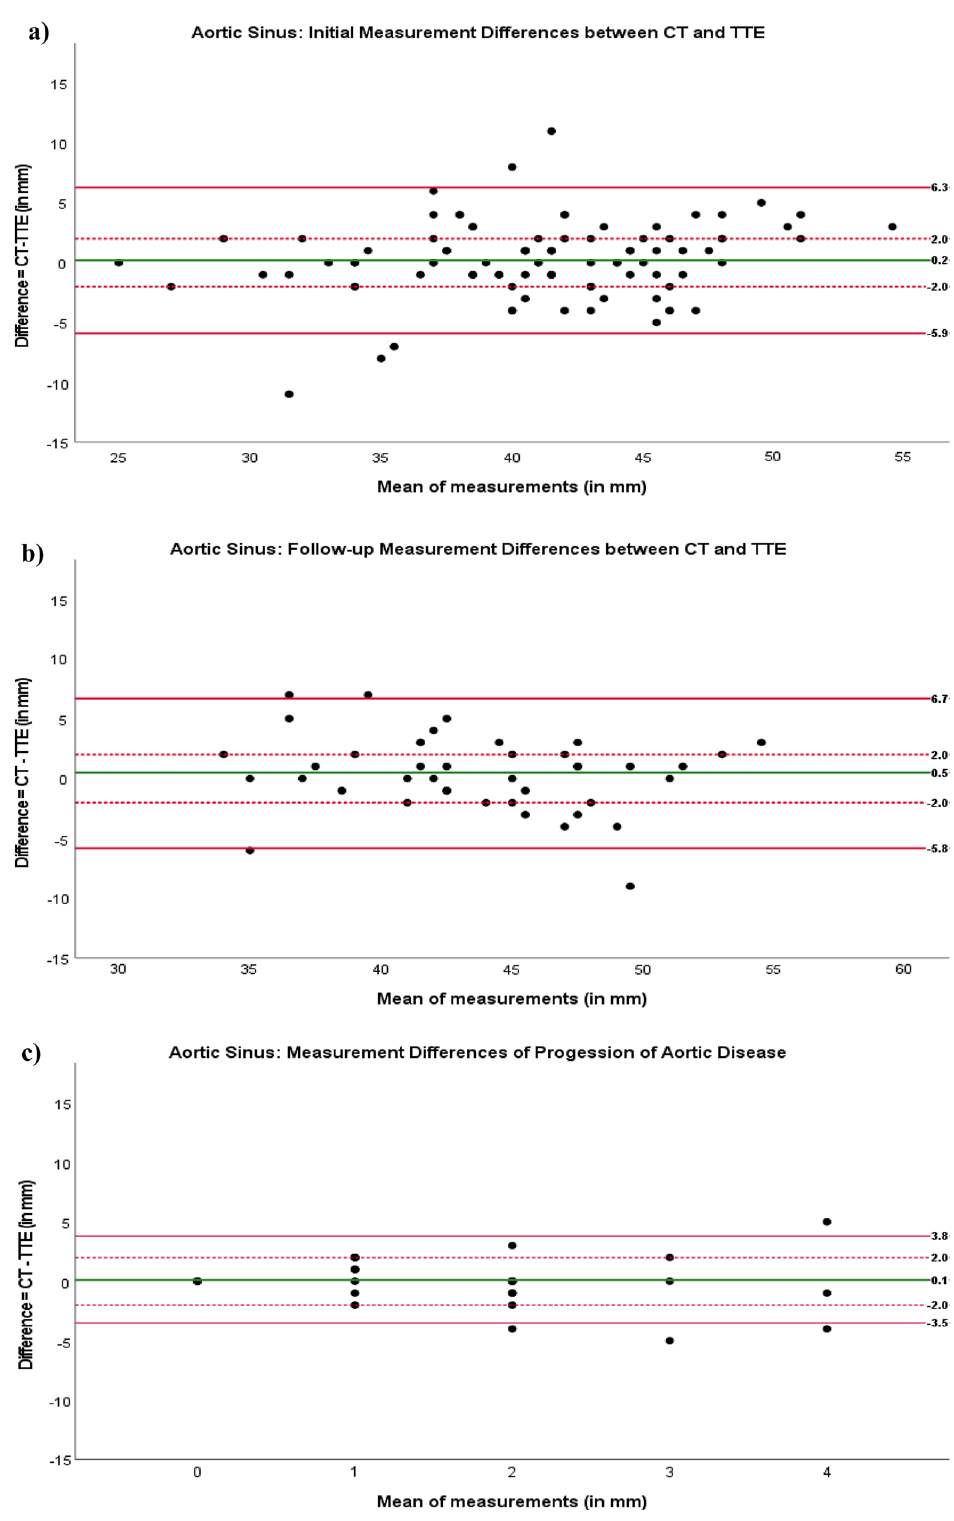
Figure 2. Bland–Altman plots for analysis of measurement differences in aortic sinus diameter in patients with Marfan syndrome or a related disorder for ( a ) initial work-up, ( b ) follow-up, and ( c ) progression of aortic disease. Red lines: upper and lower limits of agreement. Dotted red line: clinically acceptable limit of agreement for difference. Green line: agreement